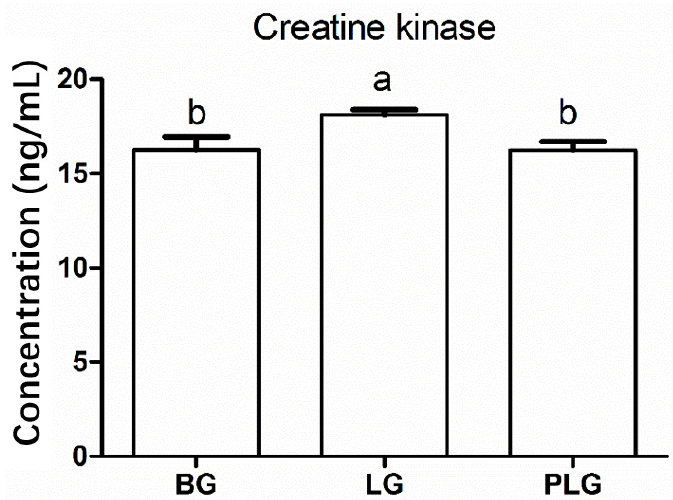
Figure 3. The plasma creatine kinase levels (in ng/mL) of chicks in the barren life challenge, for the three treatment groups: BG, barren environment group; LG, environment enriched with a litter materials group; PLG, environment enriched with perches and a litter materials group. Bars with different letters indicate that the means were statistically different ( p < 0.05).